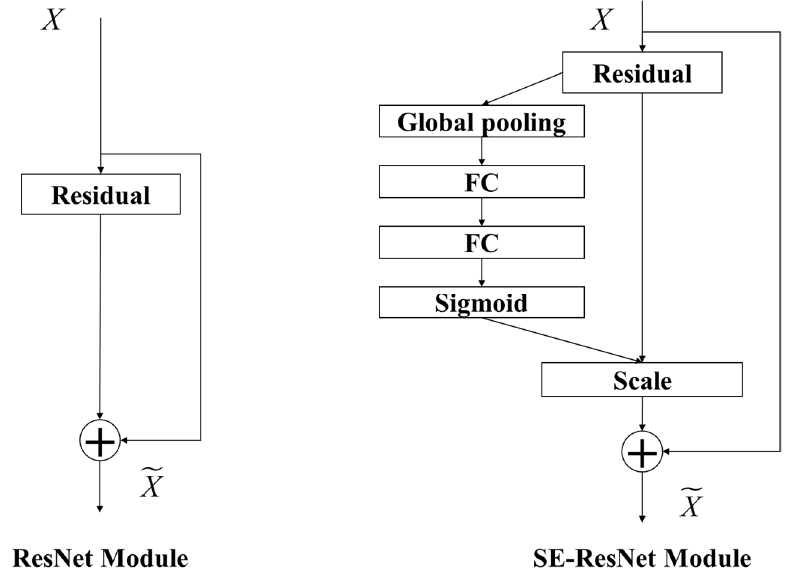
Figure 5. Standard 2D and 3D